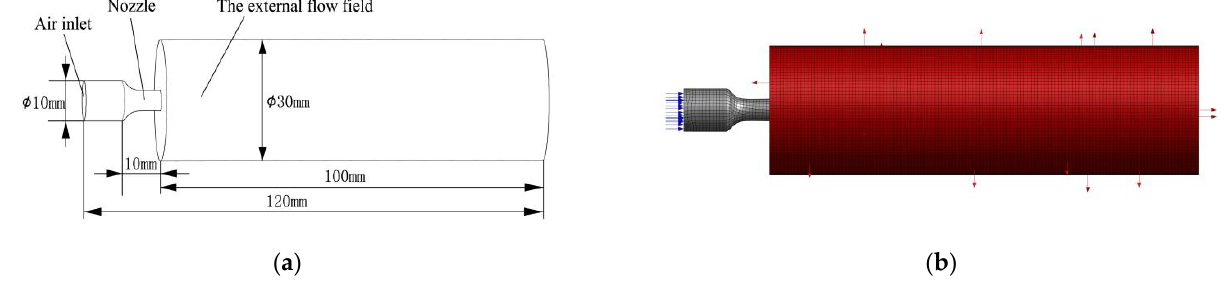
Figure 9. Simulation models and meshing: ( a ) simulation model; ( b ) simulation meshing.